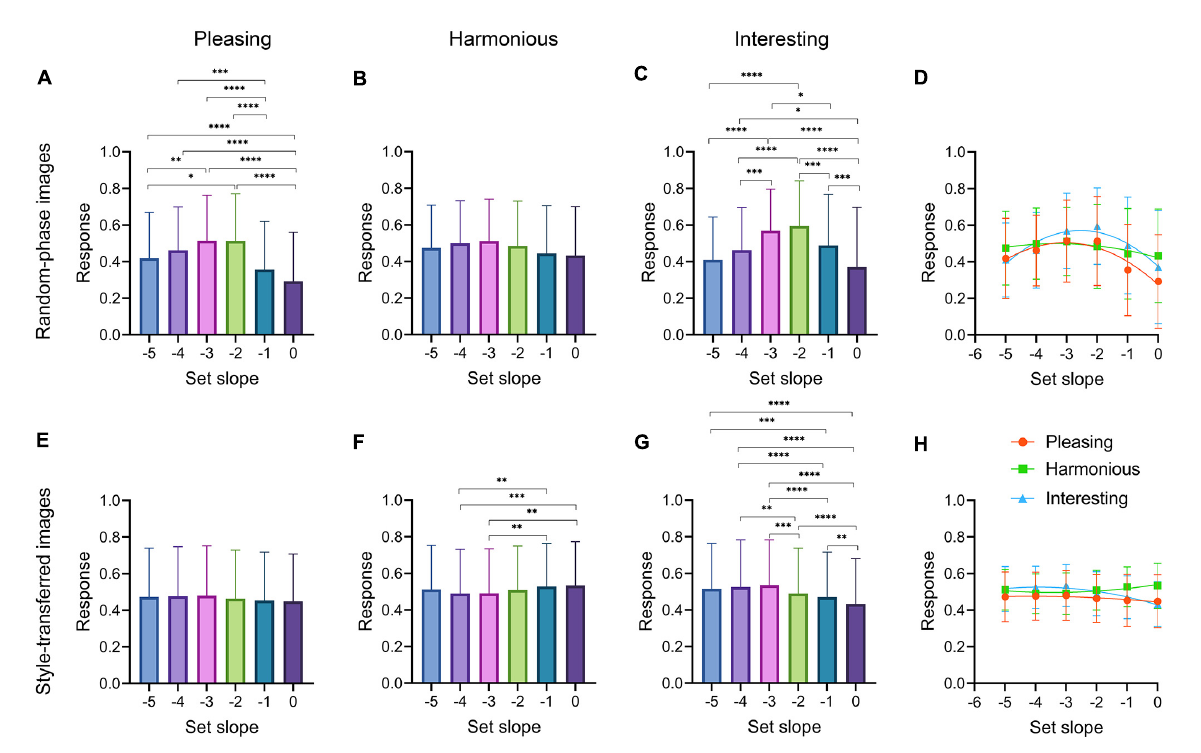
FIGURE6 Rating responses for set slope values of the random-phase images. The boxplots show mean responses (y-axis) by all 40 participants for different set Fourier spectral slopes (-5 to 0; x-axis) of the random-phase images (A–C) and the style-transferred images (E–G) . The whiskers represent the 5 – 95% confidence intervals. The rating dimensions are indicated on the top of the panels [ (A,E) Pleasing; (B,F) Harmonious; and (C,G) Interesting]. Multiplicity-adjusted significance levels of pairwise comparisons are indicated by the asterisks ( ∗ p < 0.05; ∗∗ p < 0.01; ∗∗∗ p < 0.001; ∗∗∗∗ p < 0.0001). Panels (D) and (H) show least-square fittings of second-order polynomial (quadratic) functions to the data from the previous three panels ( orange , Pleasing; green , Harmonious; and blue ,